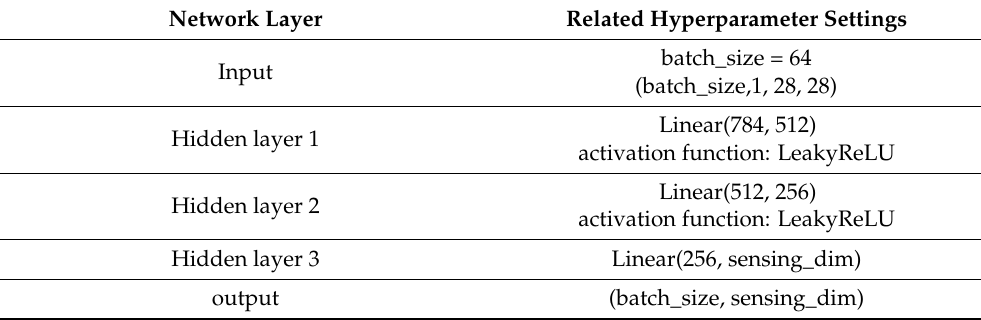
Table 5. Hyperparameter Settings of multi-layer perceptron deep observation network. Network Layer Related Hyperparameter